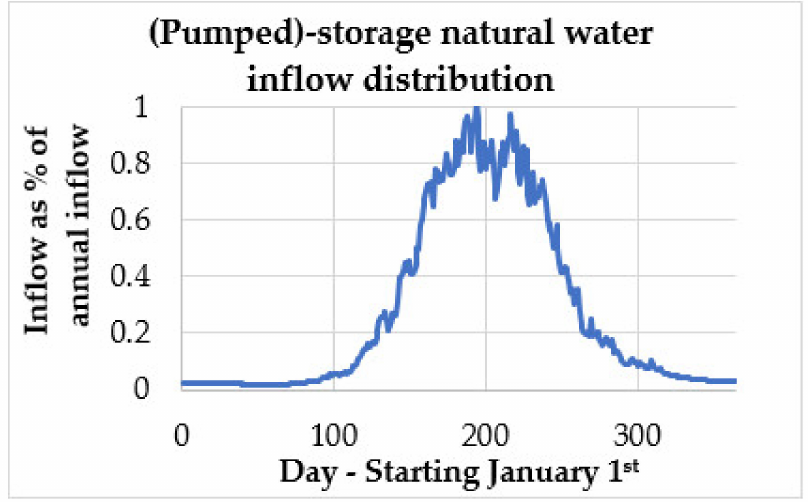
Figure 12. Annual (pumped)-storage hydropower plant natural inflow distribution. The scenario-dependent generation and consumption profile for (pumped)-storage hydropower plants is described in the following